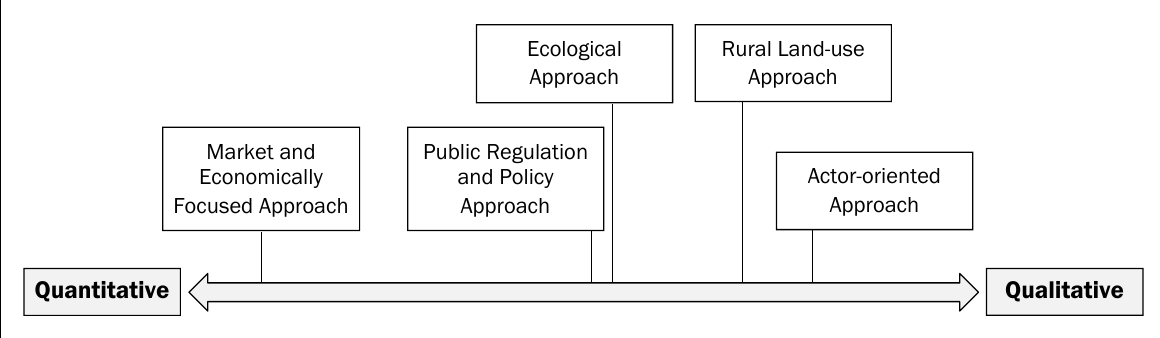
Figure 1. Placement of Approaches to Multifunctionality on the Qualitative-Quantitative